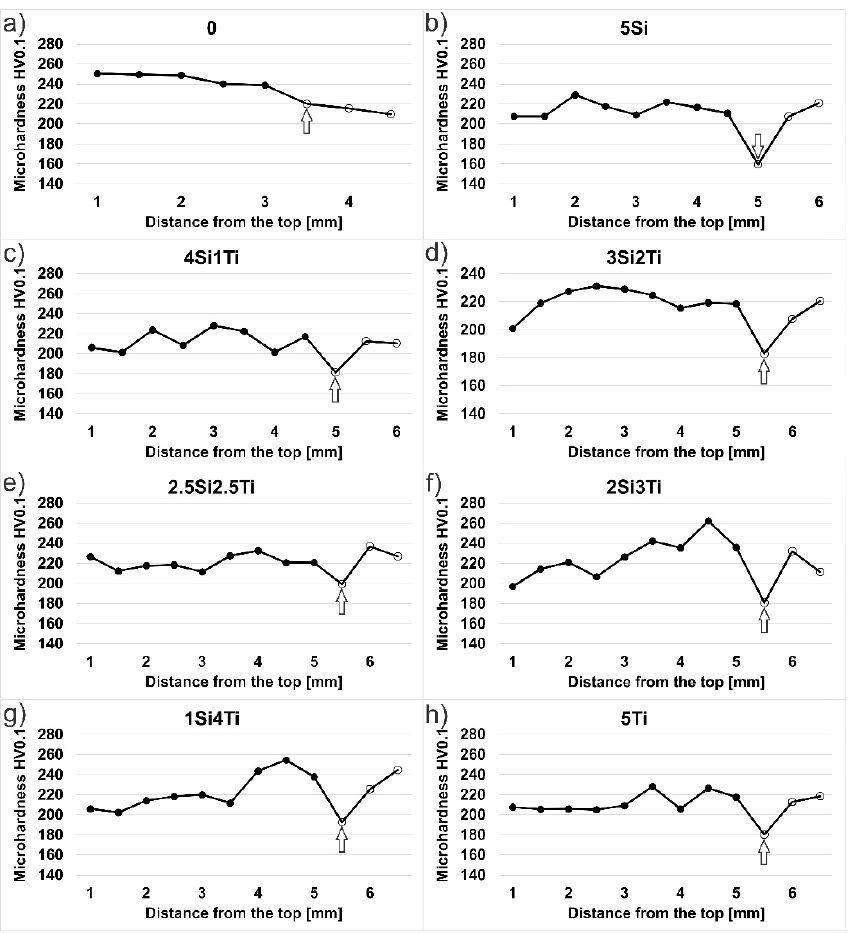
Figure 7. Microhardness values measured in Line 3: ( a ) specimen 0; ( b ) specimen 5Si; ( c ) 4Si1Ti; ( d ) 3Si2Ti; ( e ) 2.5Si2.5Ti; ( f ) 2Si3Ti; ( g ) 1Si4Ti; ( h ) 5Ti. Table 1. Average microhardness values for Lines 1, 2, and 3 measured in the weld metal.